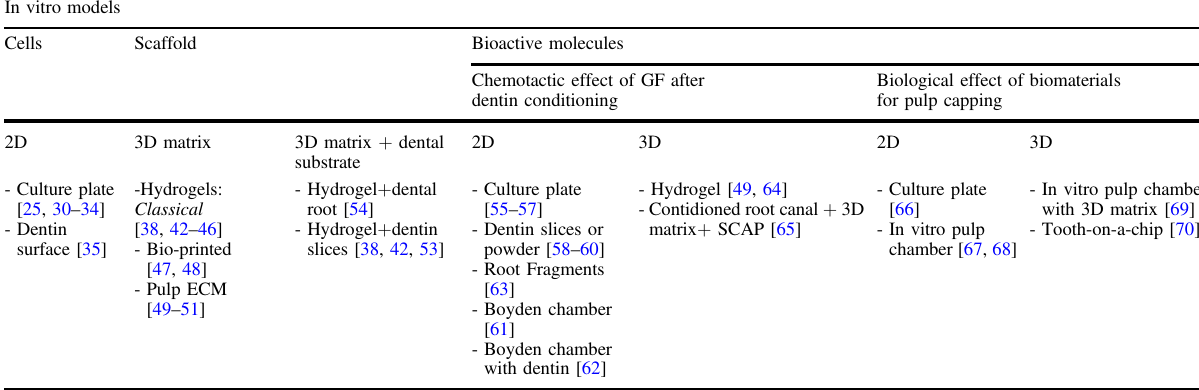
Table 2 In vitro models for dental pulp regeneration In vitro models